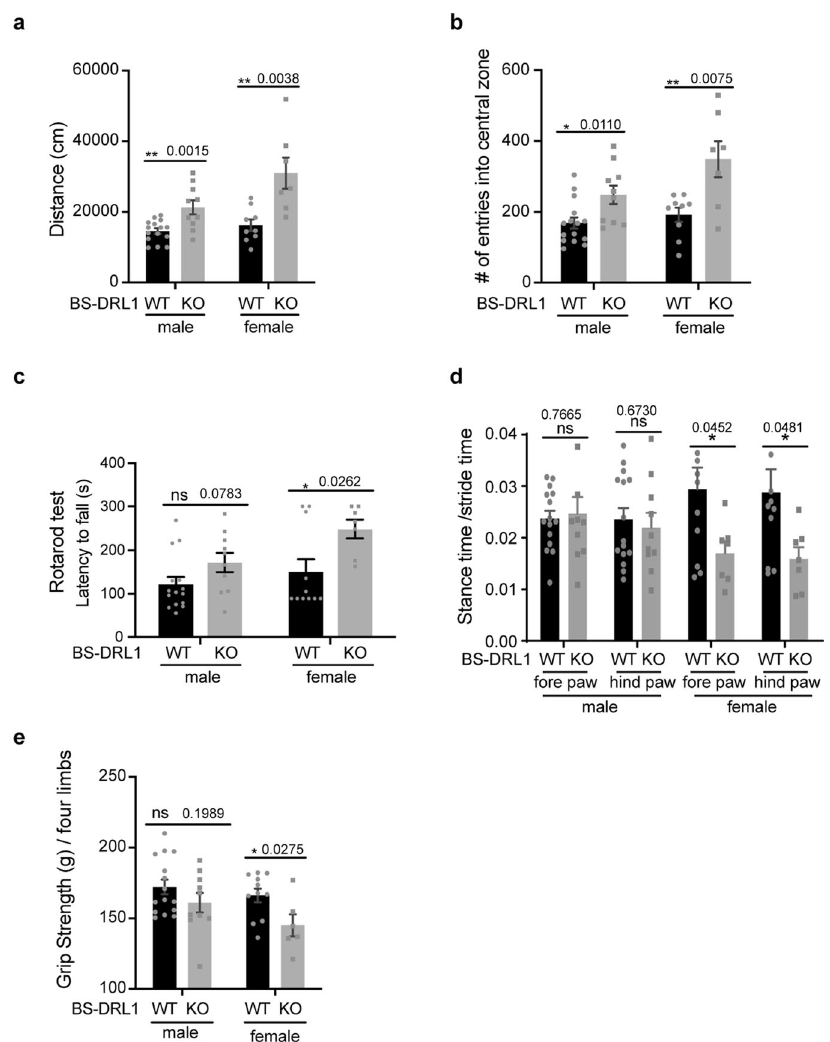
Fig. 6 BS-DRL1 KO mice show motor de fi ciency. a , b Open fi eld test showing signi fi cantly higher total traveling distance and more times of entry into the central zone of the arena in 6-month-old BS-DRL-1 KO mice compared to the littermate controls. Data are presented as mean ± SD. Male, n = 15:10; female, n = 9:7. * p < 0.05, ** p < 0.01. c An increase of latency to fall was observed in rotarod test of 6-month-old BS-DRL-1 KO female mice compared to the littermate controls. Data are presented as mean ± SD. Male, n = 15:10; female, n = 11:7. * p < 0.05, ns not signi fi cant. d Gait analysis of 6-month-old BS-DRL- 1 KO female mice. Representative example shows the percentage of stance time/stride time of four limbs. Data are presented as mean ± SD. Male, n = 15:10; female, n = 11:7. * p < 0.05, ns not signi fi cant. e Grip strength is impaired in BS-DRL-1 KO female mice compared to the littermate controls. Data are presented as mean ± SD. Male, n = 15:10; female, n = 11:7. * p <